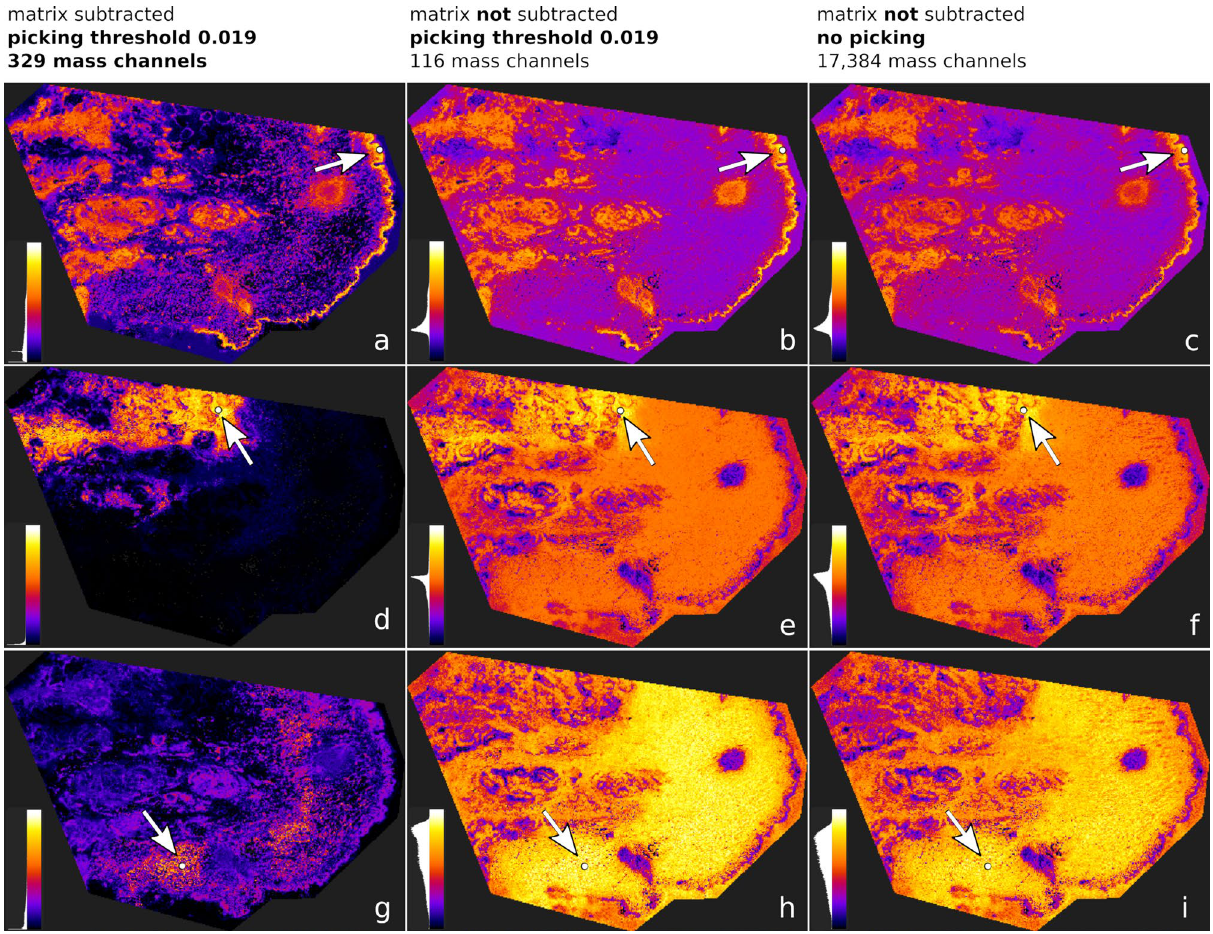
Figure 9. Comparison of QUIMBI visualization with and without matrix subtraction. The column on the left ( a ), ( d ), ( g ) shows the QUIMBI visualization of three different reference pixels (marked with arrows) in the human PXE skin data set, which was fully processed with ProViM. The matrix signal was subtracted and the picking threshold was set to 0.019, resulting in 329 mass channels. The columns in the middle ( b ), ( e ), ( h ) and on the right ( c ), ( f ), ( i ) show the QUIMBI visualizations at the same pixel position of the same data set but without matrix subtraction. The image intensity scales in all images show the similarity of pixels from black (dissimilar) to white (similar). In the middle, mass channels with the same threshold value of 0.019 were picked, resulting in 116 mass channels. For the right column no picking was performed, resulting in 17,384 mass channels in the QUIMBI visualization. The best color contrast between the similar and dissimilar pixels in the QUIMBI visualization is achieved when a matrix subtraction was